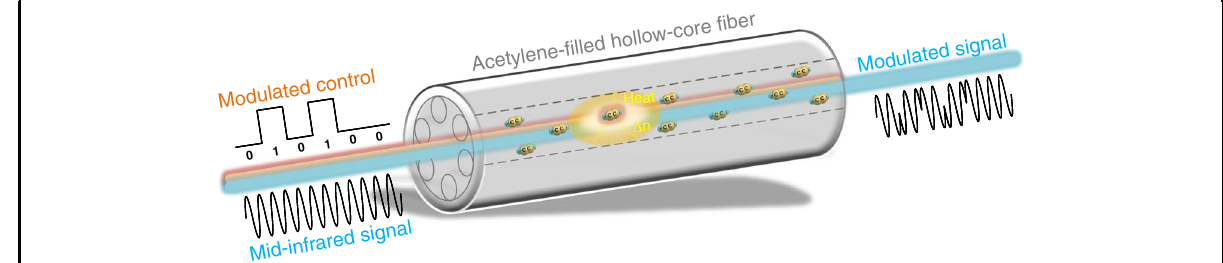
Fig. 1 Schematic of mid-infrared optical modulator enabled by photothermal effect in a gas- fi lled hollow-core fi